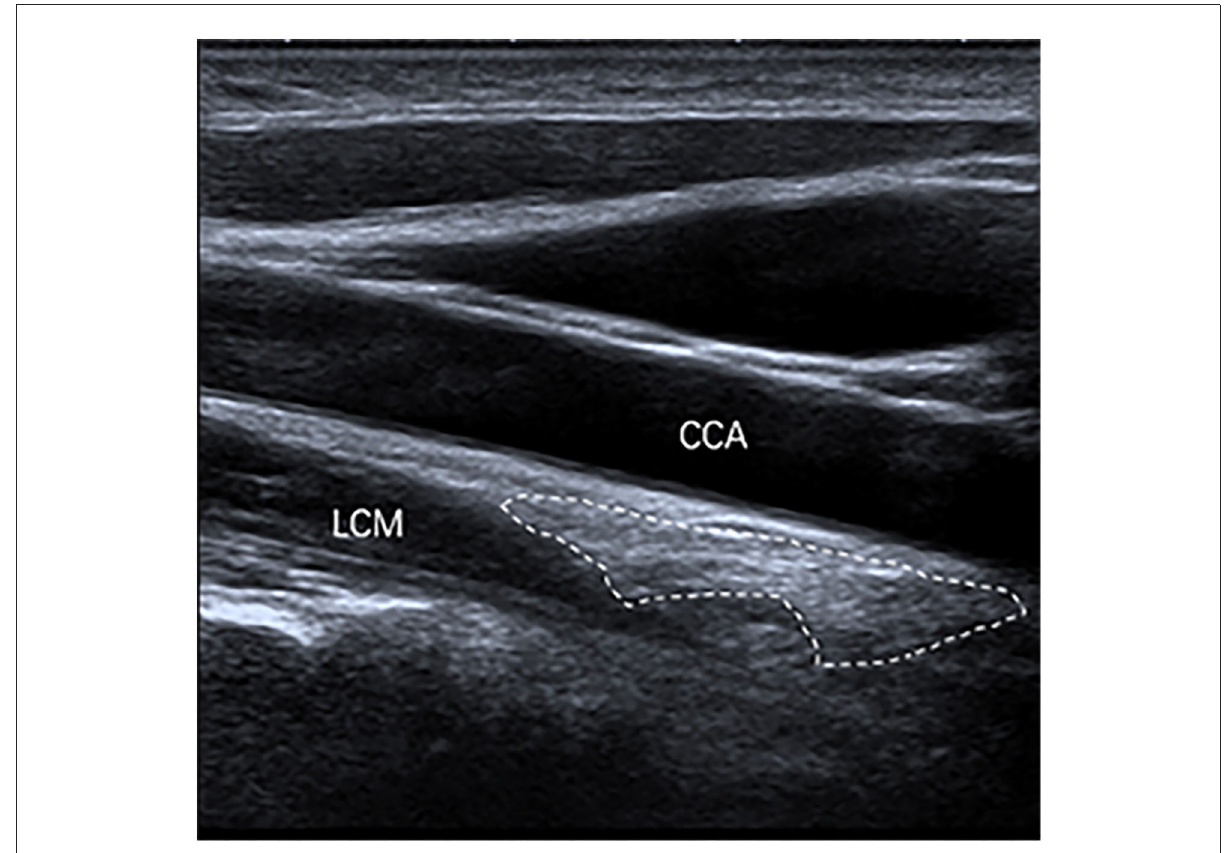
FIGURE4 The SG, with a dumbbell shape (outlined) and hyperechogenicity, was located between the common carotid artery (CCA) and the longus colli muscle (LCM) on the longitudinal ultrasound